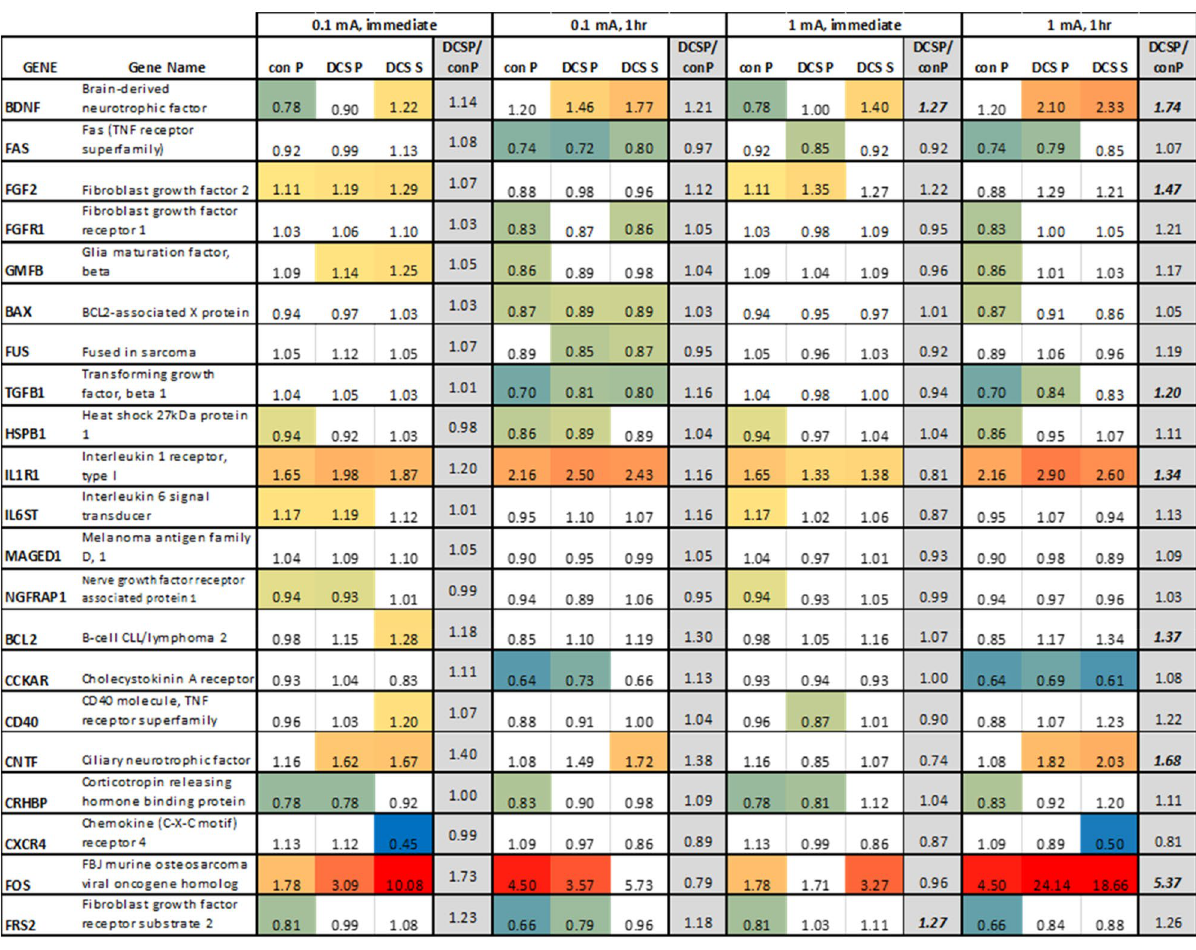
Figure 3. Relative gene expression for human astrocytes exposed to DCS for 10 min at 0.1 mA or 1 mA with RNA collected immediately or after 1 h. Con P- samples with a hydrostatic pressure gradient that induces convective flow; DCS P- samples with a hydrostatic pressure gradient plus DCS; DCS S- samples under static conditions with DCS. Expression shown relative to static control used as calibrator for RT-qPCR. The statistically significant changes are color coded using a 3-color gradient scale where blue to green = downregulation, yellow = onefold, orange = upregulation, and red = > fivefold upregulation. N > 7 for all cases. Statistical significance determined by Wilcoxon signed rank test with p < 0.05 considered significant. DCS P/con P – shows the fold difference between these samples. Values shown in bold italics denote statistical significance DCS P versus con P by Student’s t Test with p < 0.05 considered significant. Full mean + SEM data set shown in supplementary information Fig.